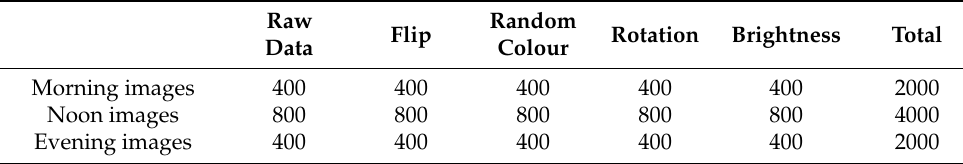
Table 2. Number of images generated by data